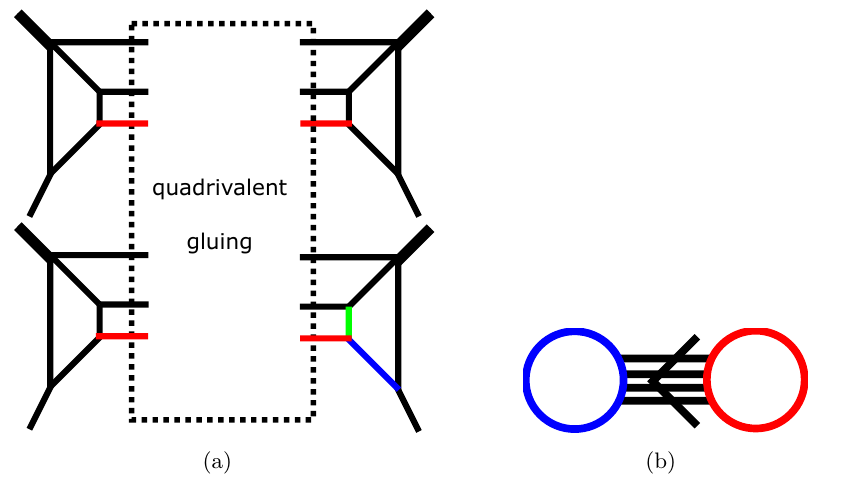
Figure 5. (a): The web diagram of the theory obtained after the Higgsing (2 , 2 , 2 , 2) . (b): The Dynkin diagram of the twisted affine Lie algebra su (3) (2) . The lines in red and blue in figure 5(a) correspond to the nodes in red and blue in this figure